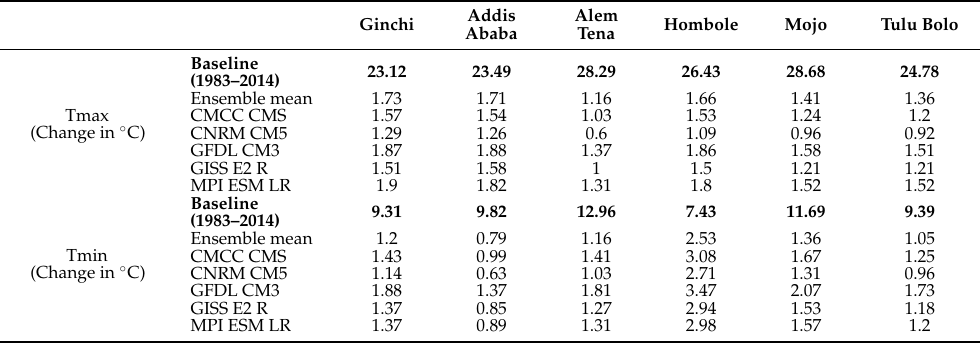
Table 7. Annual maximum and minimum temperature trend for the baseline period and projected by each of the GCMs at different stations (S is Sen’s slope ( ◦ C) and Z is the Z-test). Variable GCMs Addis